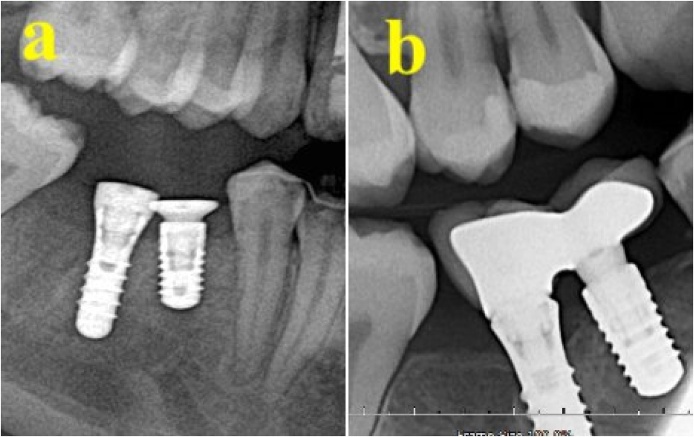
(A) Two implants after insertion, with healing cap. (B) 12 months after loading of the two implants.